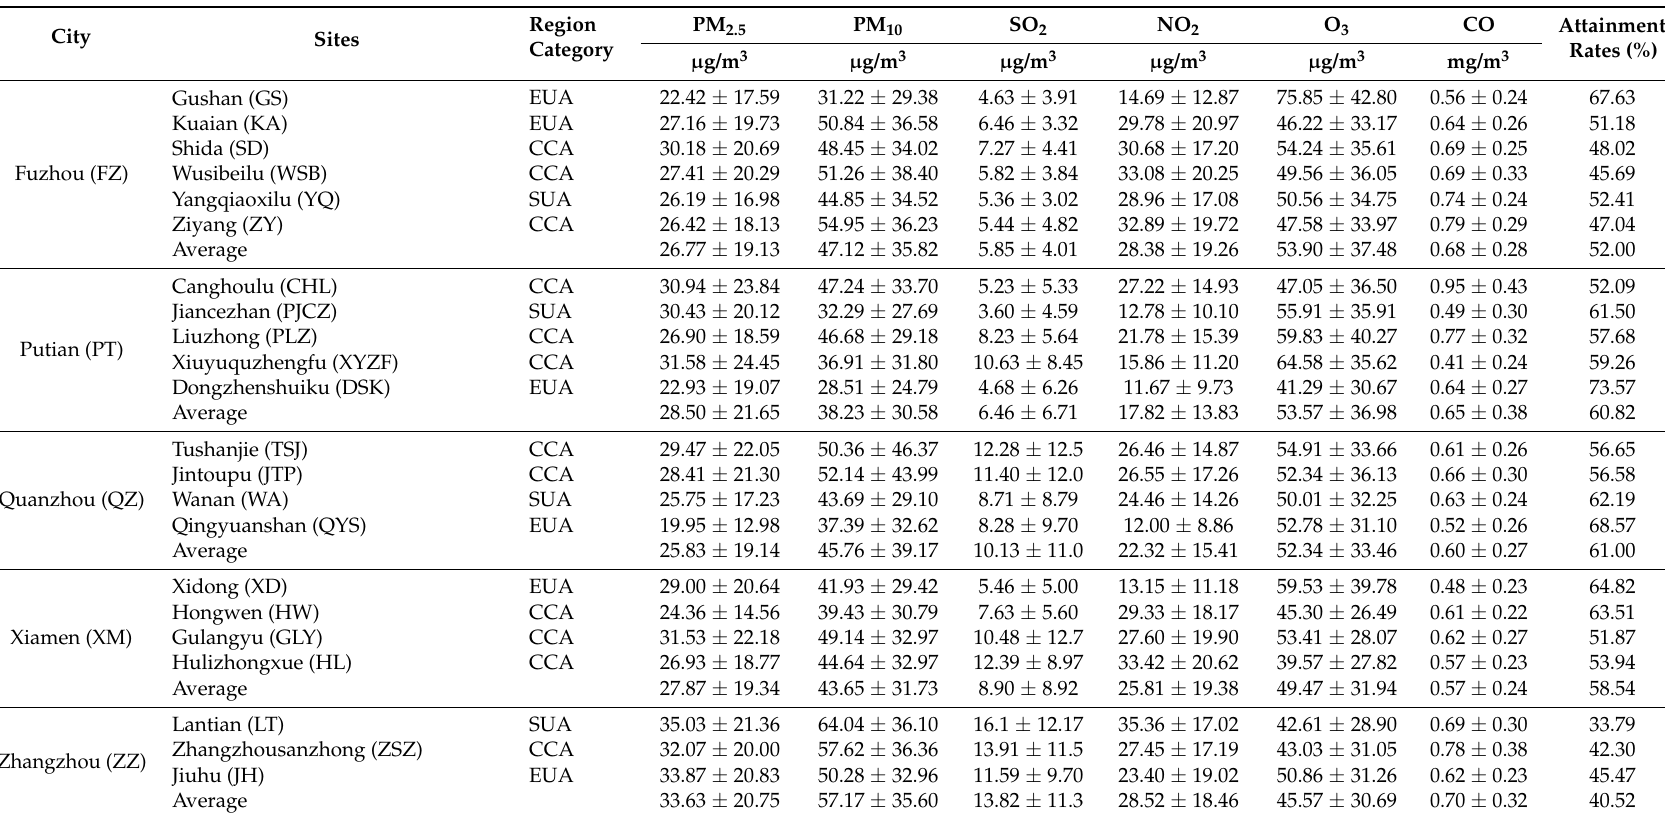
Table 2. Mean concentrations (mass ± standard deviation) of six criteria air pollutants and attainment rates (all the air pollutants below Grade I standards by CAAQS) in the 37 monitoring sites including 20 sites in city central areas (CCA), 8 in the suburban areas (SUA) and 9 in the exurban areas (EUA) in all the 9 major cities